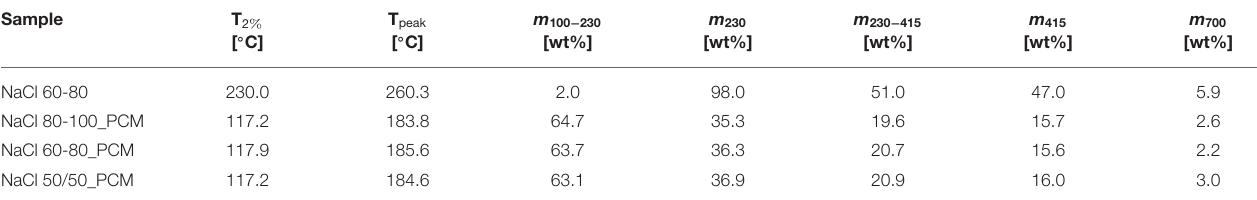
TABLE 2 | Results of the thermogravimetric analysis (TGA) tests of the EPDM and TES-EPDM foams.